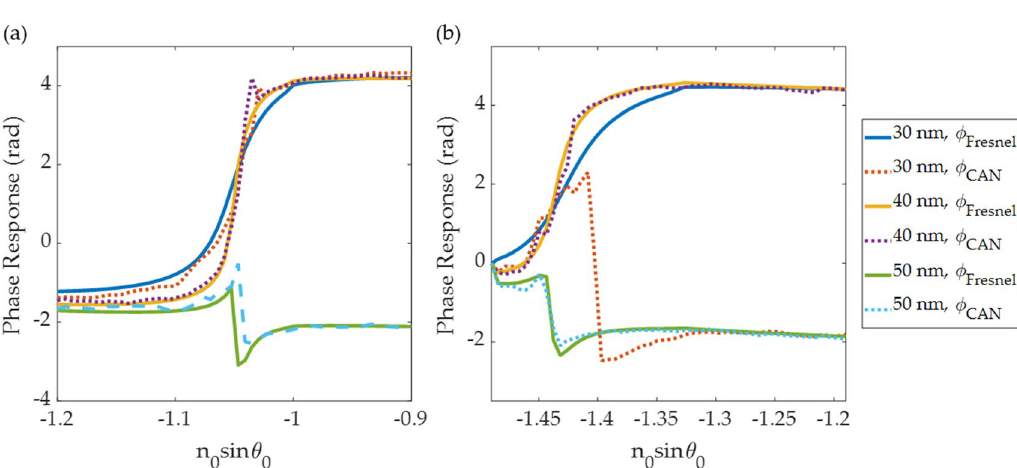
Figure 9. Input/output for the CAN and corresponding phase profiles from Fresnel equations for ( a ) d m of 30 nm and n s of 1.00, ( b ) d m of 40 nm and n s of 1.00, ( c ) d m of 50 nm and n s of 1.00, ( d ) d m of 30 nm and n s of 1.33, ( e ) d